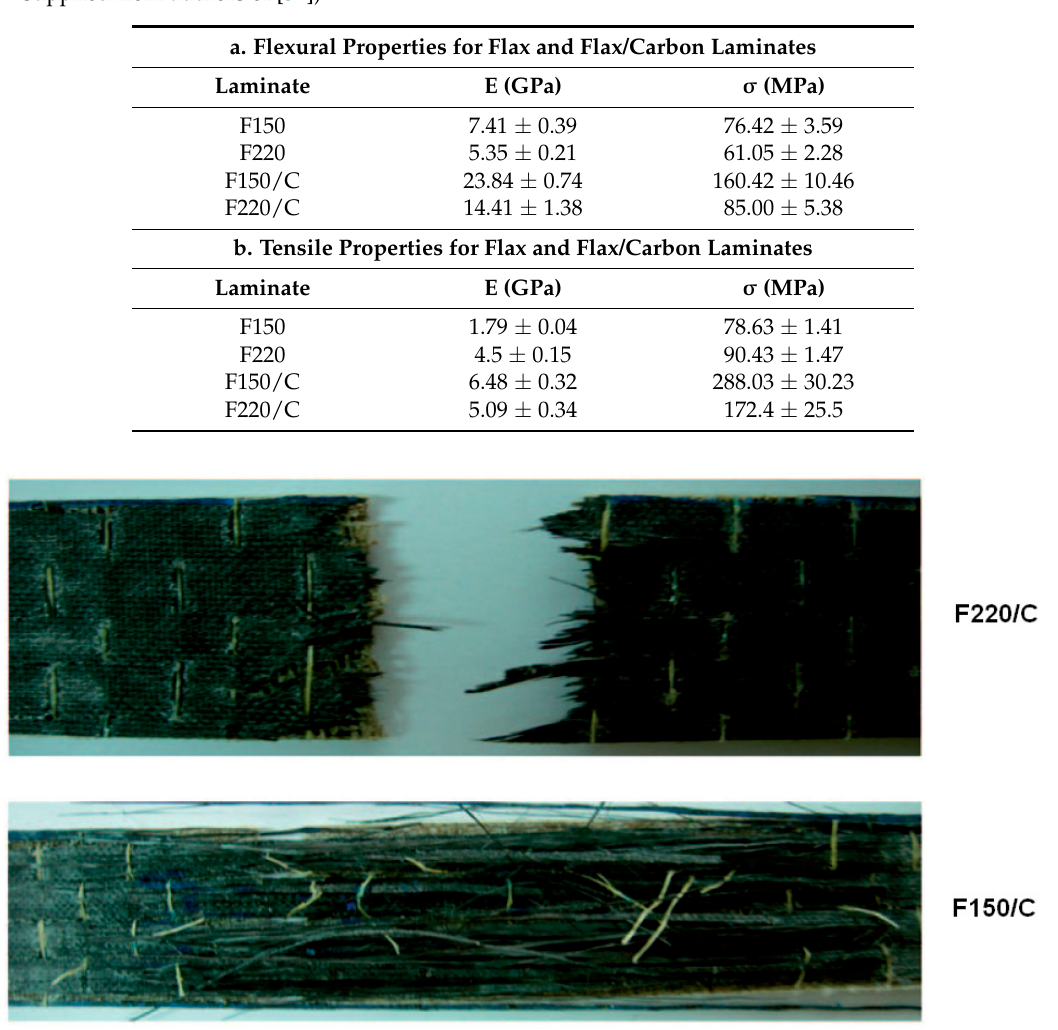
Figure 10. The tensile fracture of the carbon/flax hybrid laminates.